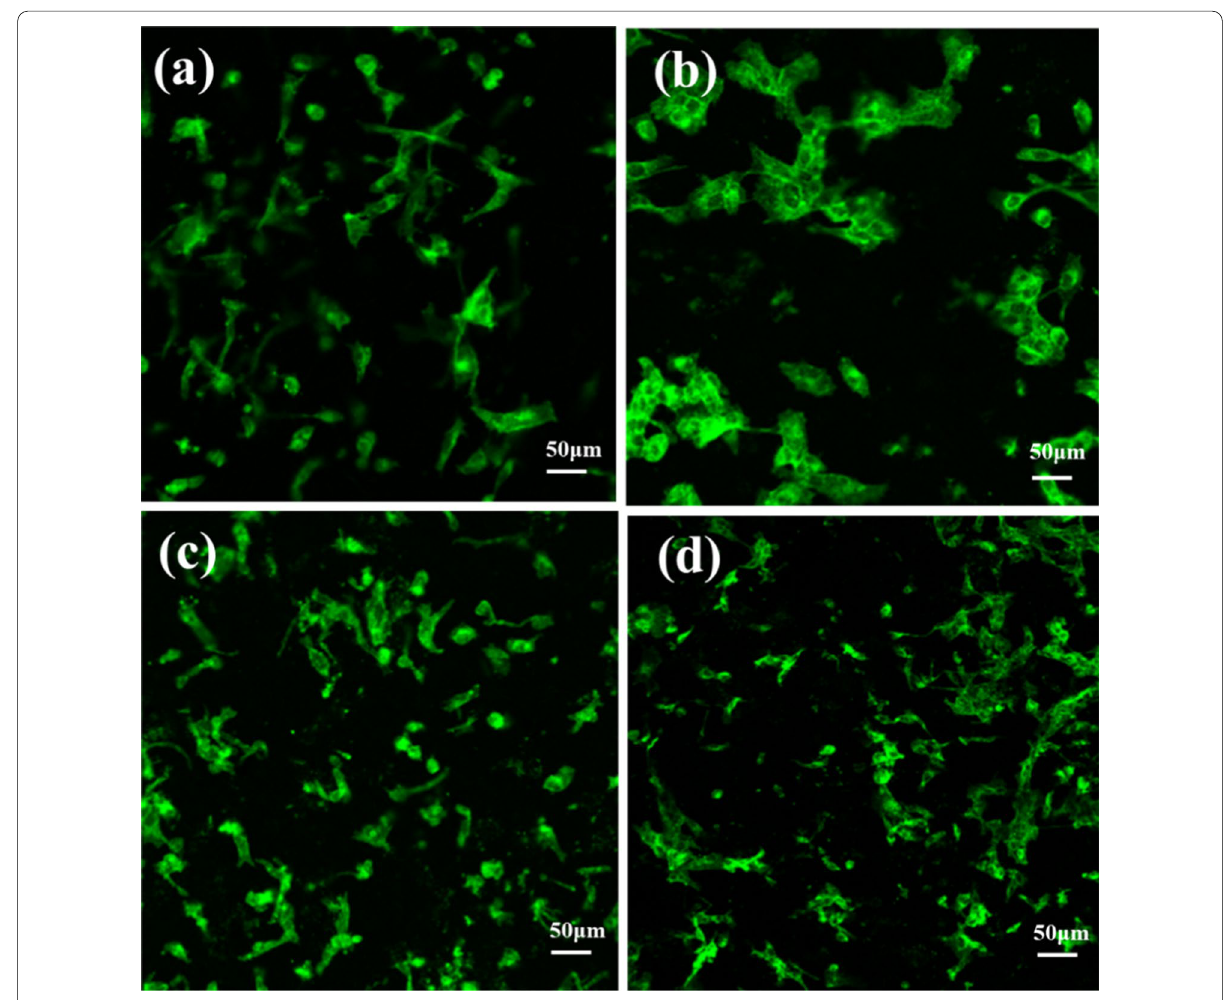
Fig. 10 Fluorescence micrographic images on a PLA nanofibers, b PANI/PLA-HA, c PANI/PLA-SA, and d PANI/PLA-PA composite nanofibers after the incubation of 24